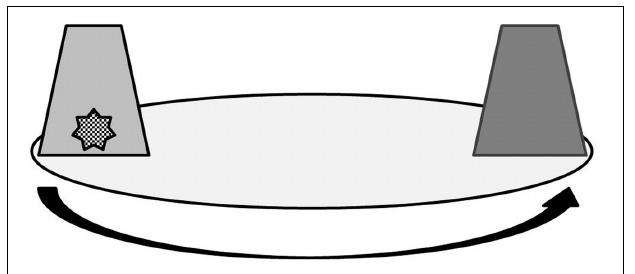
FIGURE 1 | Schematic setup of the spatial rotation